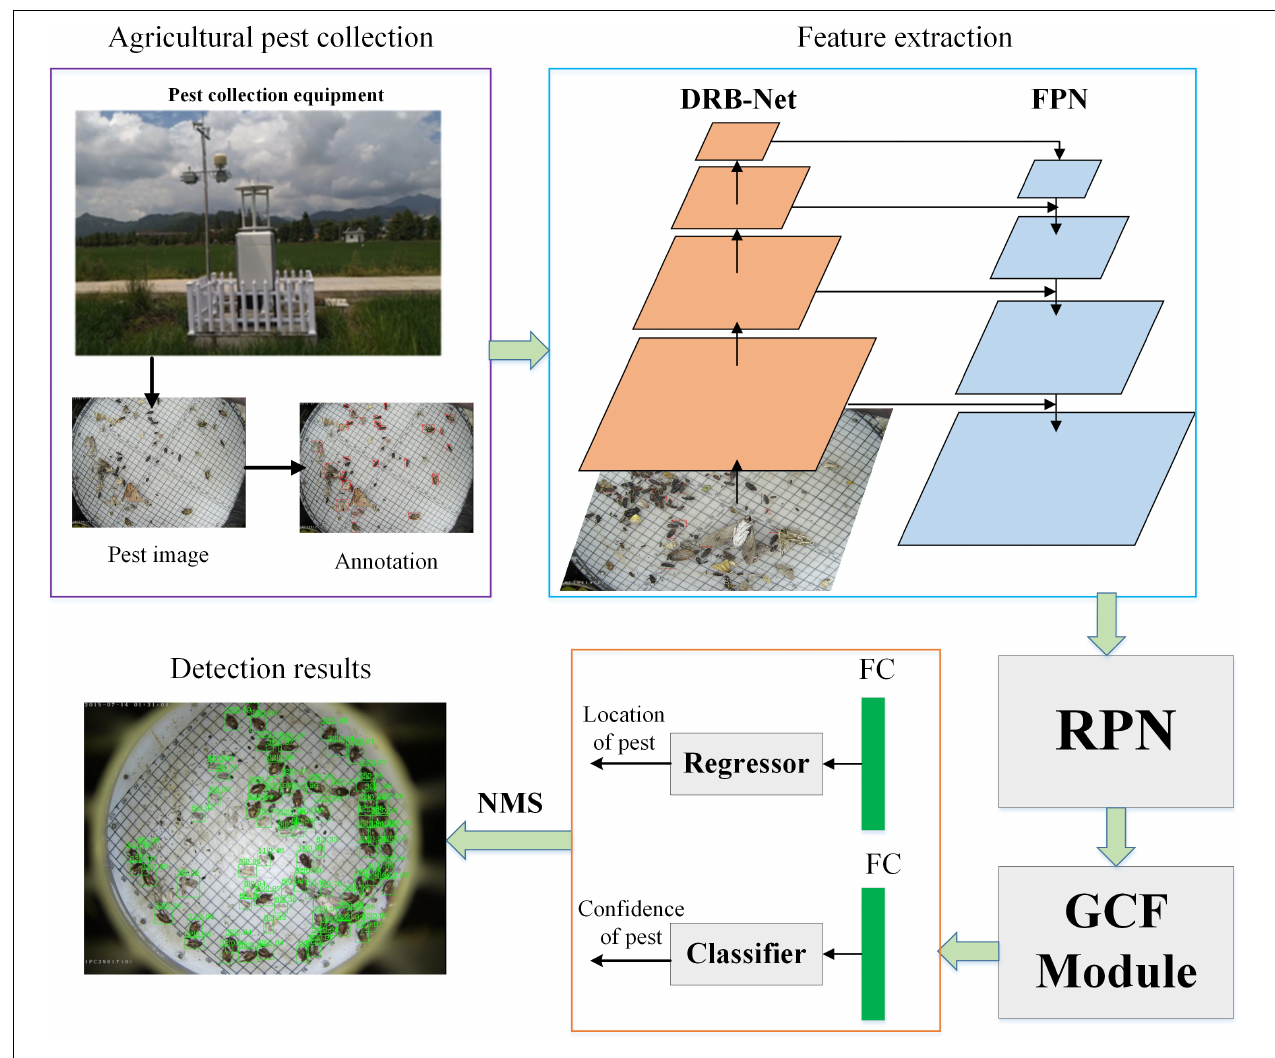
FIGURE 1 | Whole framework of agricultural pest detection. FC represents the fully connected layer.